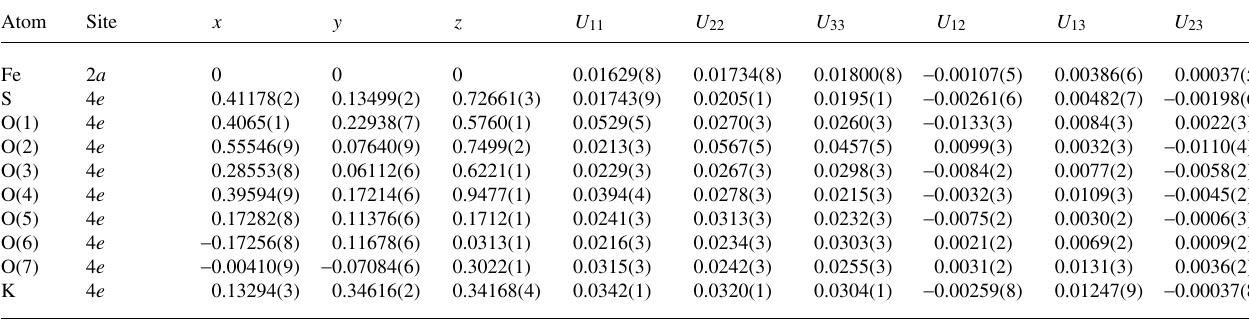
Table 3. Atomic coordinates and displacement parameters (in Å 2 ) .